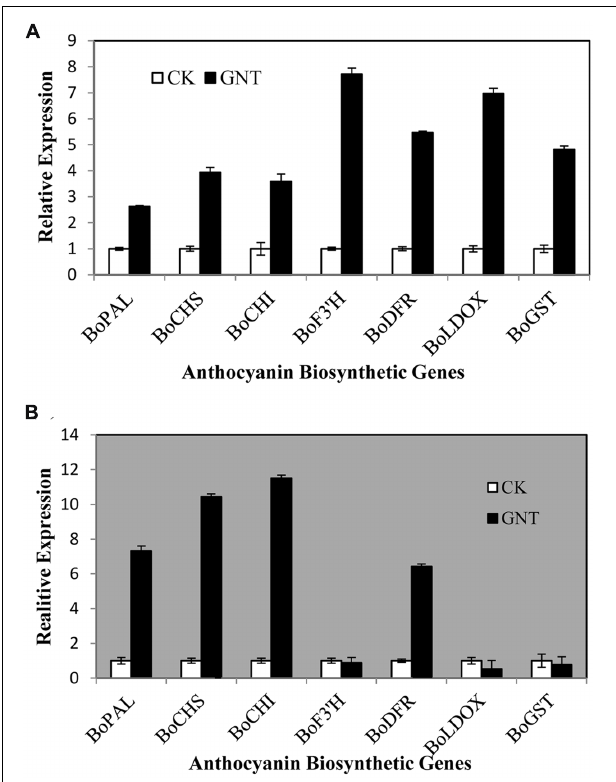
FIGURE 5 | Expression levels of genes along anthocyanin biosynthesis under genistein treatments. (A) is under light conditions and (B) is under dark conditions. The data are mean ± SD ( n = 3), Vertical bars represent ± SD .